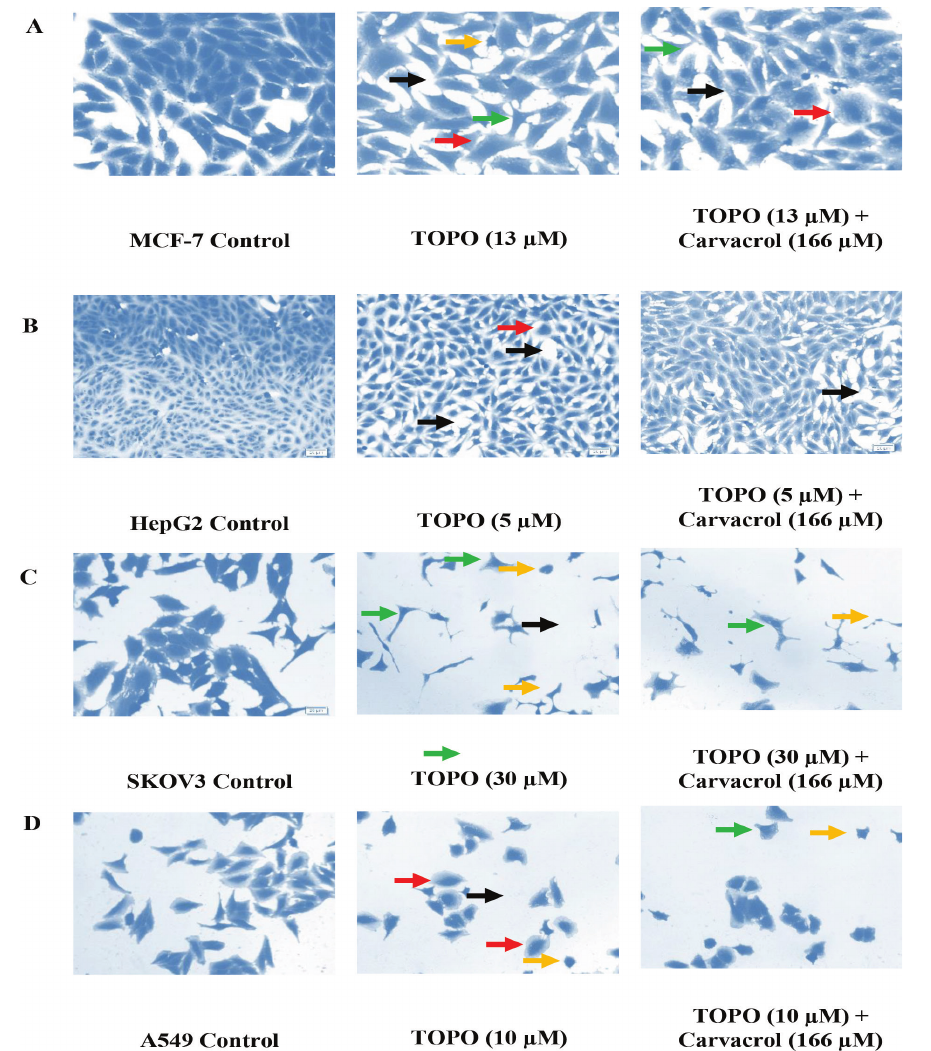
Figure 4. Light microscopy images (Scale bar: 20 µm) of (A) MCF-7, (B) HepG2, (C) SKOV3 and (D) A549 cell lines treated for 24 h with TOPO IC in the absence or presence of carvacrol (166 µM). Images were magnified at 20×. The red, green, orange and 50 black arrows represented cell enlargement with cytoplasm shrinkage, membrane blebbing, apoptotic bodies and intercellular space increase, respectively. Images were taken from at least three independent experiments with similar